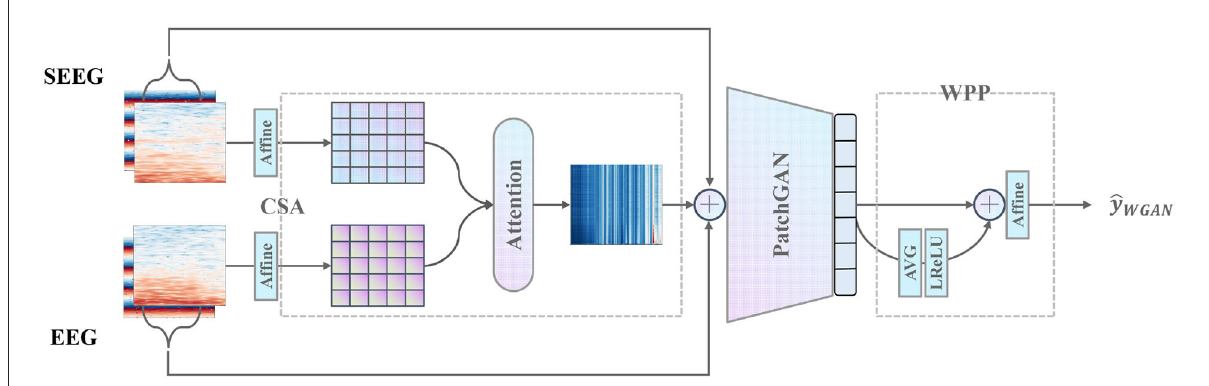
FIGURE4 Proposed discriminator with the pre-positioned CSA module capturing the frequency correlation of EEG and SEEG, and the post-positioned WPP module ensuring robust temporal